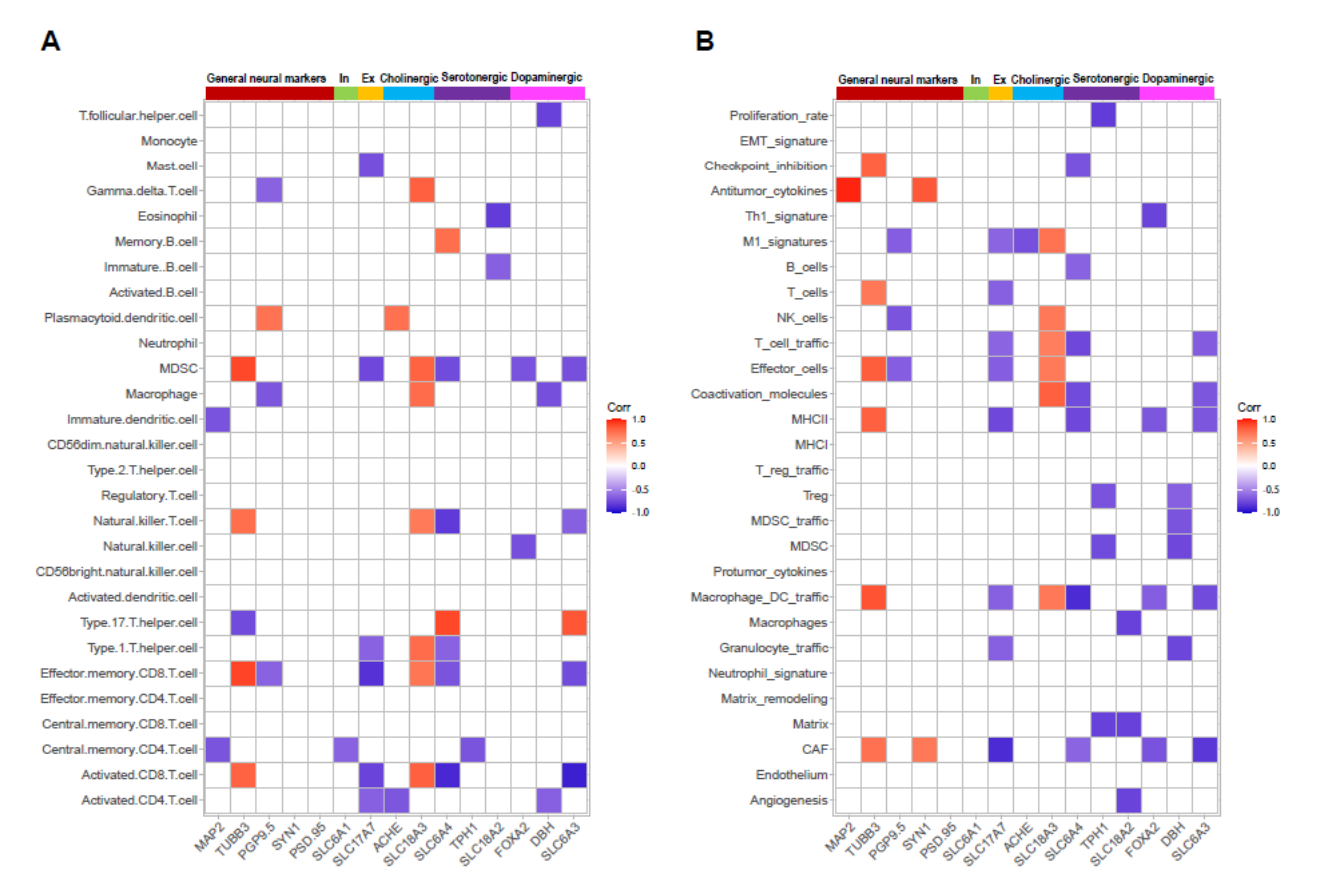
Figure 5. Correlation of neuronal markers and immune signatures. ( A , B ) The correlation between enrichment scores of 28 tumor-infiltrating immune cells ( A ), 28 tumor microenvironment-related gene sets ( B ), and TPM values of neuronal markers. The significant correlations ( p < 0.05, Pearson’s correlation) were demonstrated as a gradient of red (positive) or blue (negative) according to the coefficients.